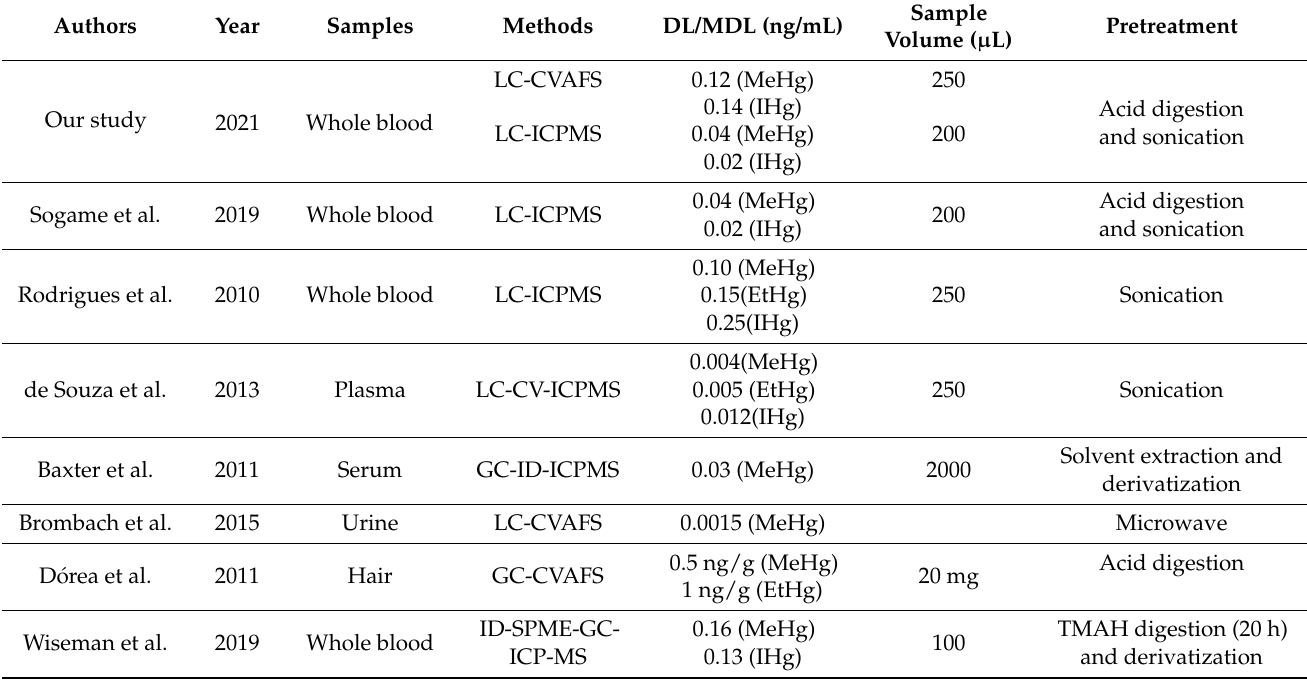
Table 6. Summary of speciation mercury analysis of biological